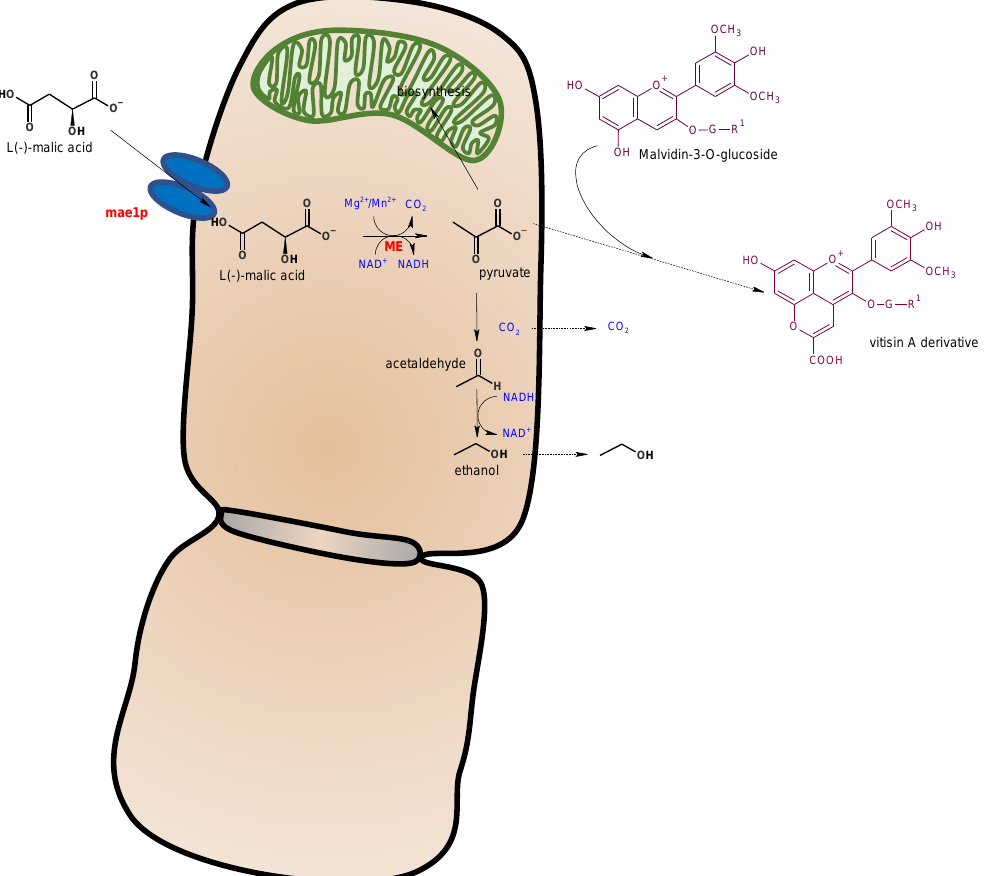
Figure 4. Maloalcoholic fermentation by Schizosaccharomyces pombe and its influence in the subsequent formation of stable vitisin A-type pigments by chemical condensation with grape anthocyanins (adapted from [17,61]).